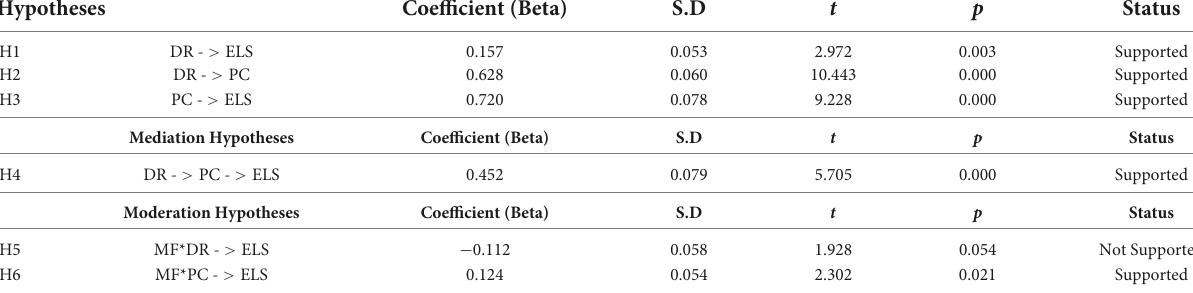
TABLE 5 Hypotheses